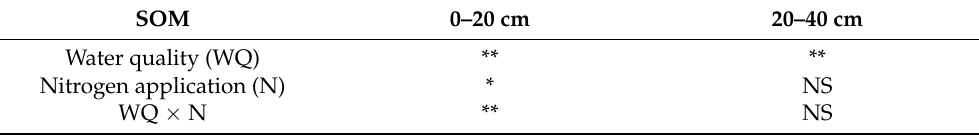
Figure 2. Effects of different irrigation treatments on soil organic matter. Note: control (CK): ground- water; PW: piggery wastewater; RW: reclaimed water; SW: saline water; H: 300 kg/ha nitrogen application; L: 200 kg/ha nitrogen application. Different letters indicate a significant level of 5% between the different treatments. Table 5. ANOVA analysis for effects of different irrigation treatments on soil organic